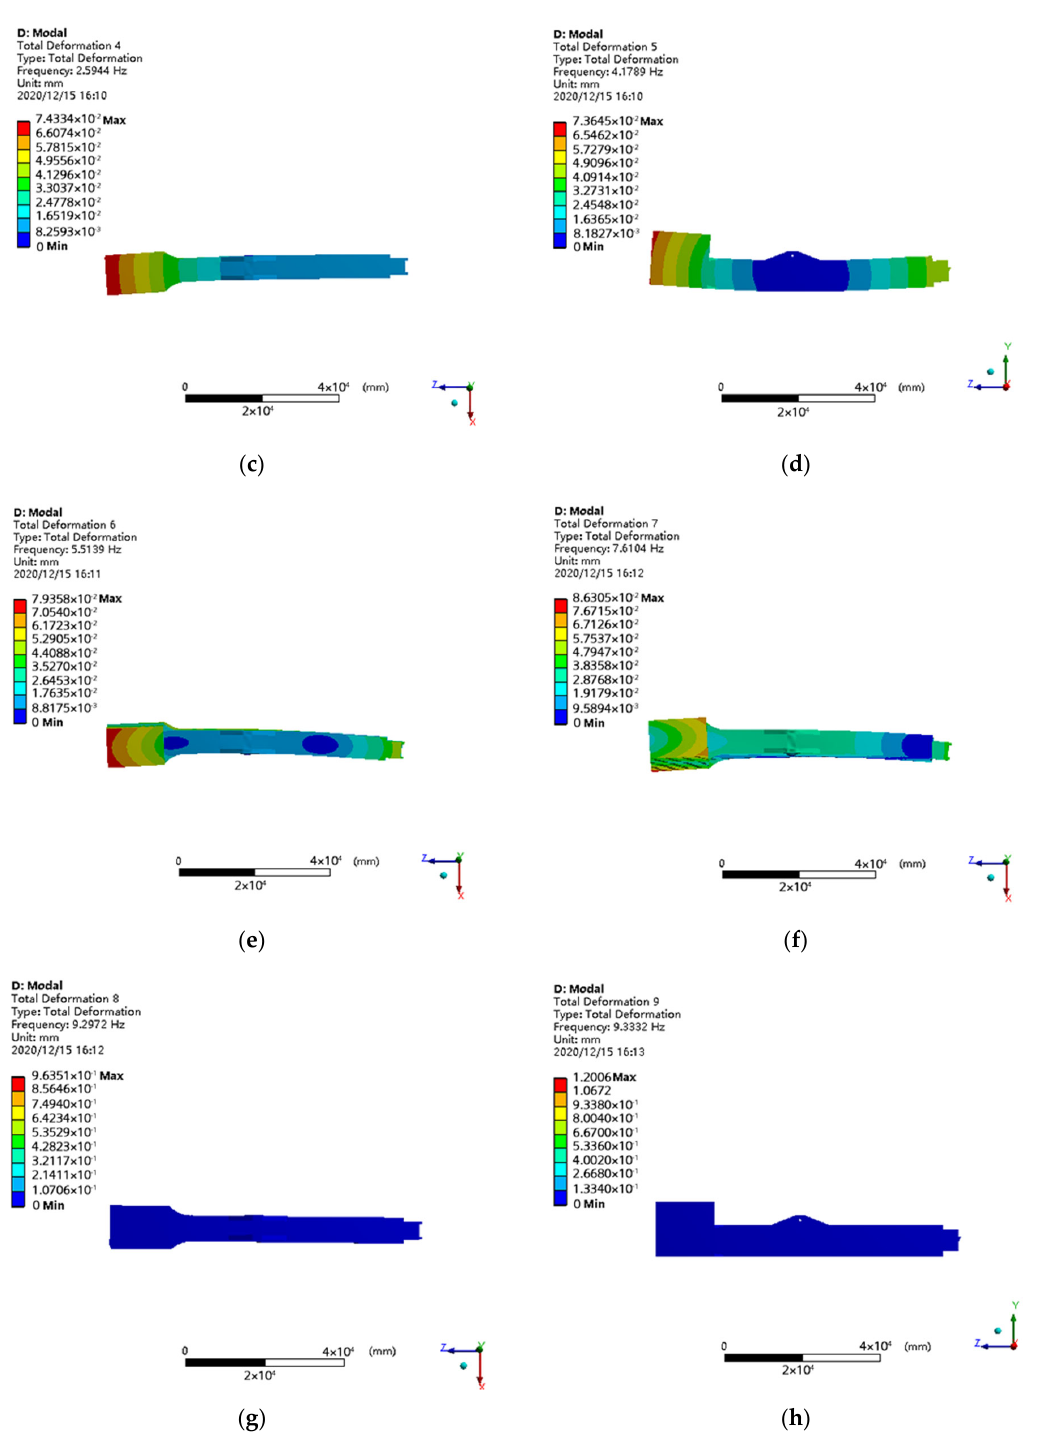
Figure 11. Modes of Vibration of the Lifting Arm at Different Frequency Orders: ( a ) 1# Order Mode of Vibration ( b ) 2# Order Mode of Vibration ( c ) 3# Order Mode of Vibration ( d ) 4# Order Mode of Vibration ( e ) 5# Order Mode of Vibration ( f ) 6# Order Mode of Vibration ( g ) 7# Order Mode of Vibration ( h ) 8# Order Mode of Vibration .